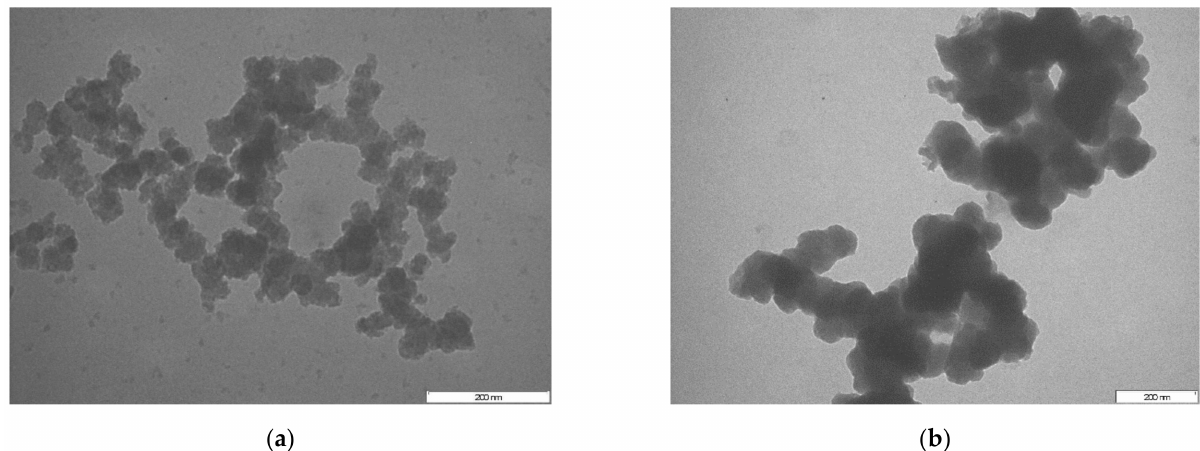
Figure 2. TEM images of ( a ) bioflocculant and ( b ) FeCu bimetallic nanoparticles